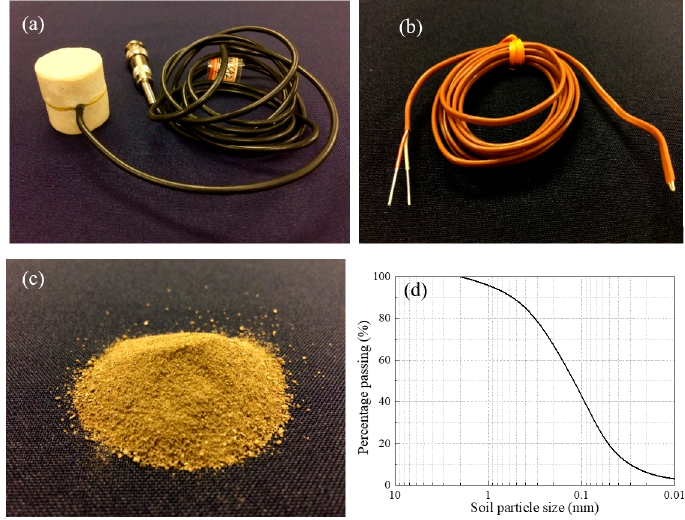
Figure 2. Experimental materials: ( a ) PZT-based smart aggregate; ( b ) K-type thermal transducer; ( c ) Soil sample; ( d ) Soil particle size distribution.